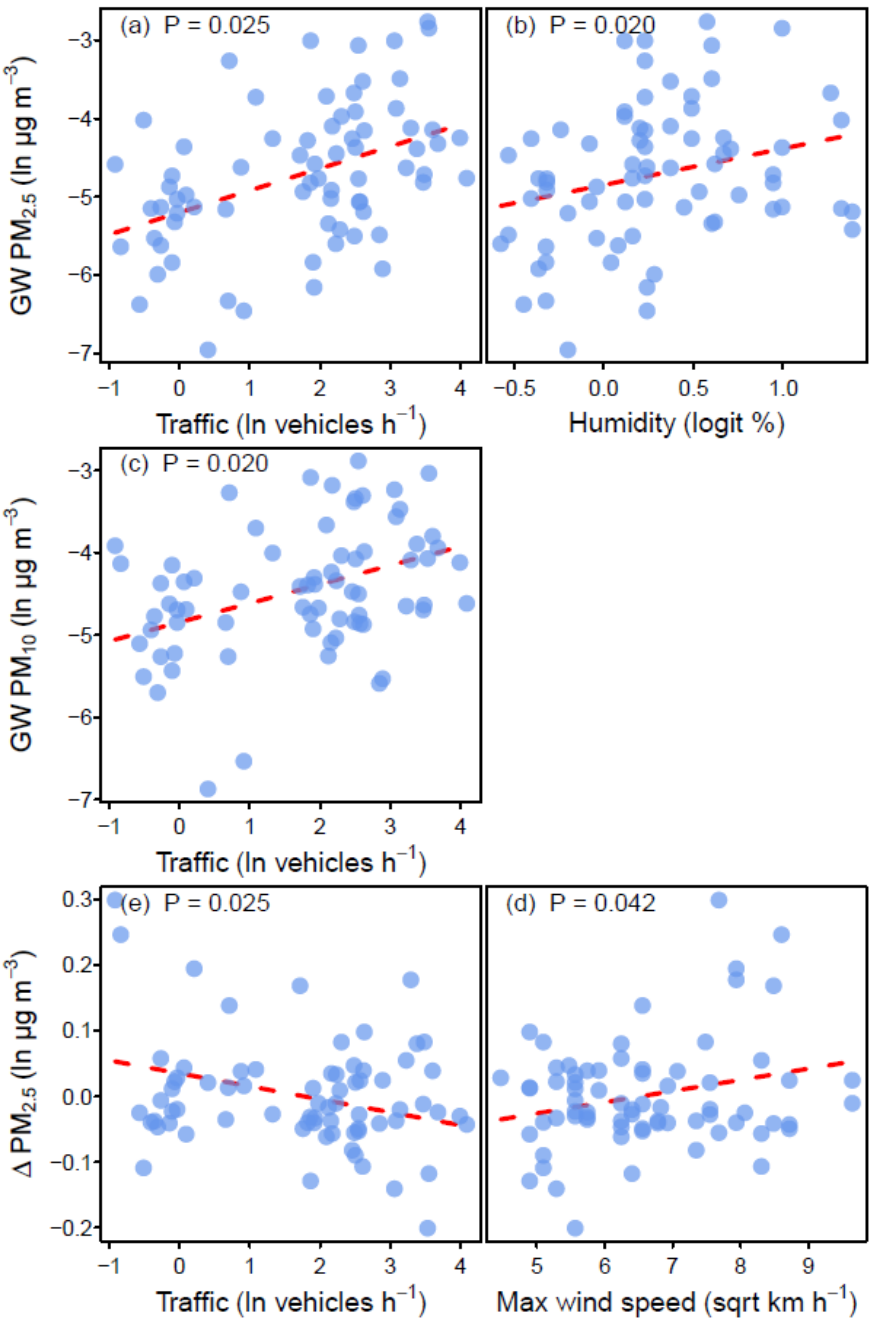
Figure 4. Scatterplots of the significant patterns emerging from the multiple regression models of ( a ) green wall PM 2.5 and tra ffi c, ( b ) green wall PM 2.5 and humidity, ( c ) green wall PM 10 and tra ffi c, ( d ) ∆ PM 2.5 and tra ffi c, and ( e ), ∆ PM 10 and max wind speed. Broken lines are coe ffi cients for the model term of interest, with p -values for the terms shown at top left of each